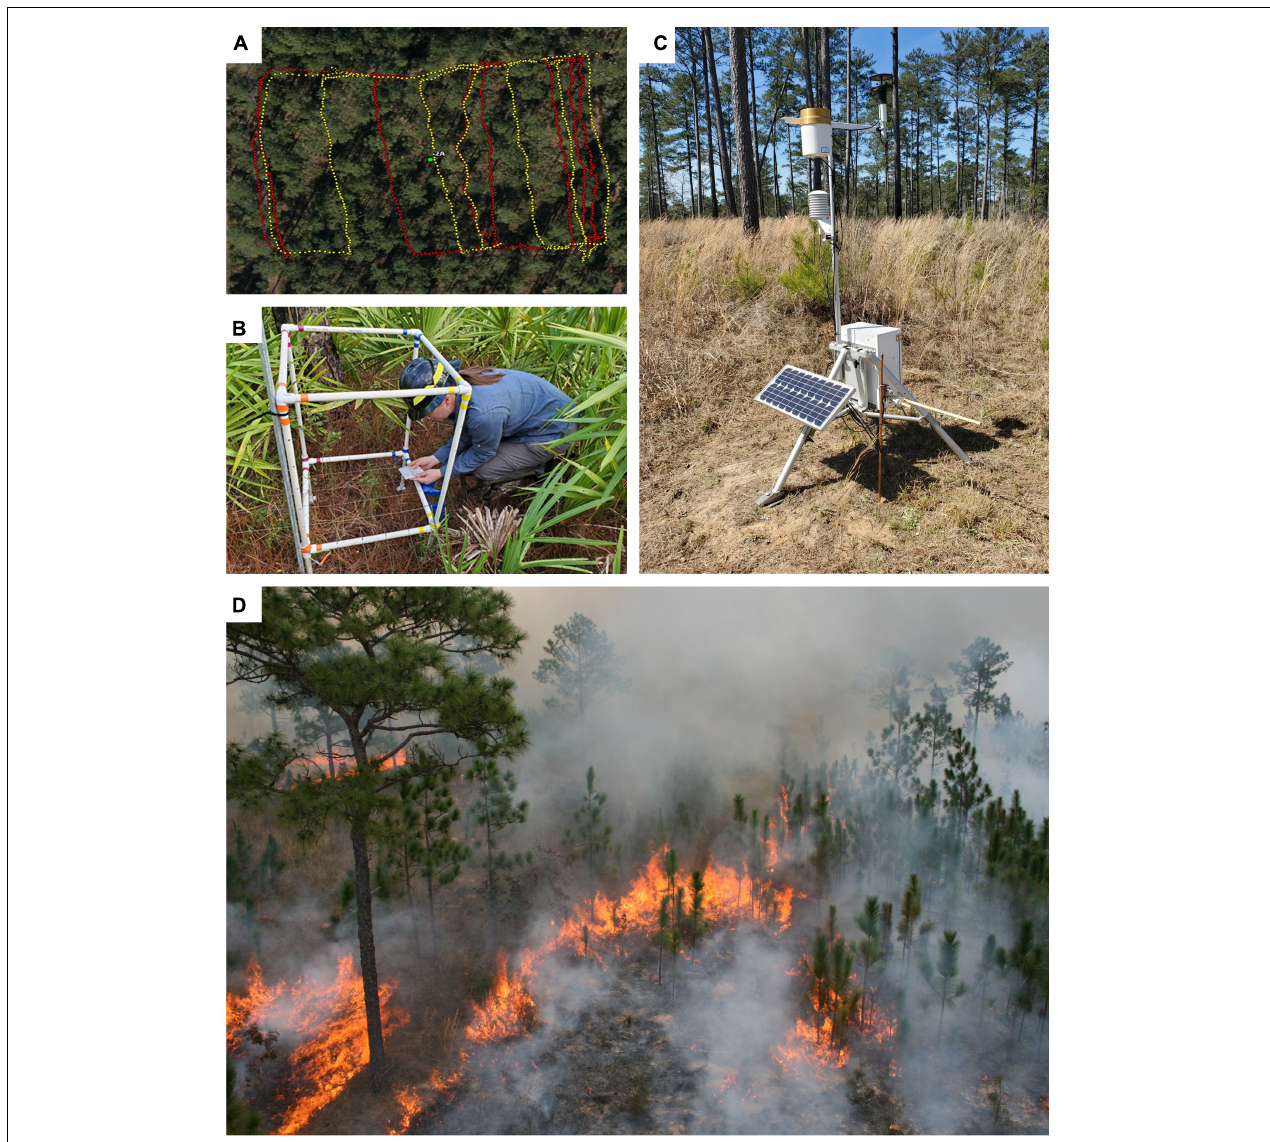
FIGURE 4 | Images of (A) Ignition pattern for an experimental prescribed fire at Tall Timbers Research Station based on GPS tracking. Ignition was conducted by two individuals (red and yellow dots) with drip torches. (B) 3-Dimensional surface fuels sampling based on the methods of Hiers et al. (2021). (C) A Campbell Scientific Remote Automated Weather Station (RAWS) used to monitor and collect data on wind speed, air temperature, relative humidity, and other meteorological conditions during prescribed burns. (D) Still shot from oblique color video of interacting fire lines during a 2012 prescribed burn at Eglin Air Force Base,